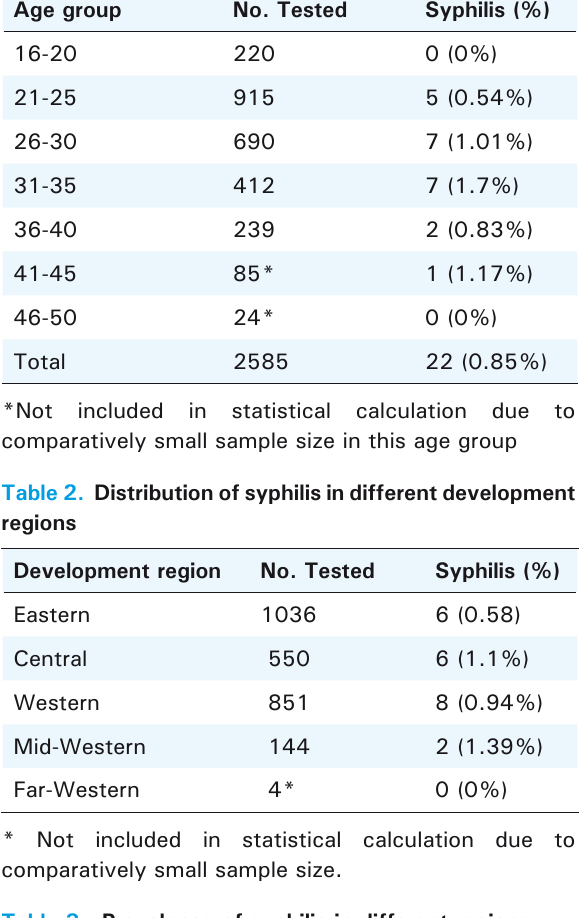
table 3. Prevalence of syphilis in different regions Region total